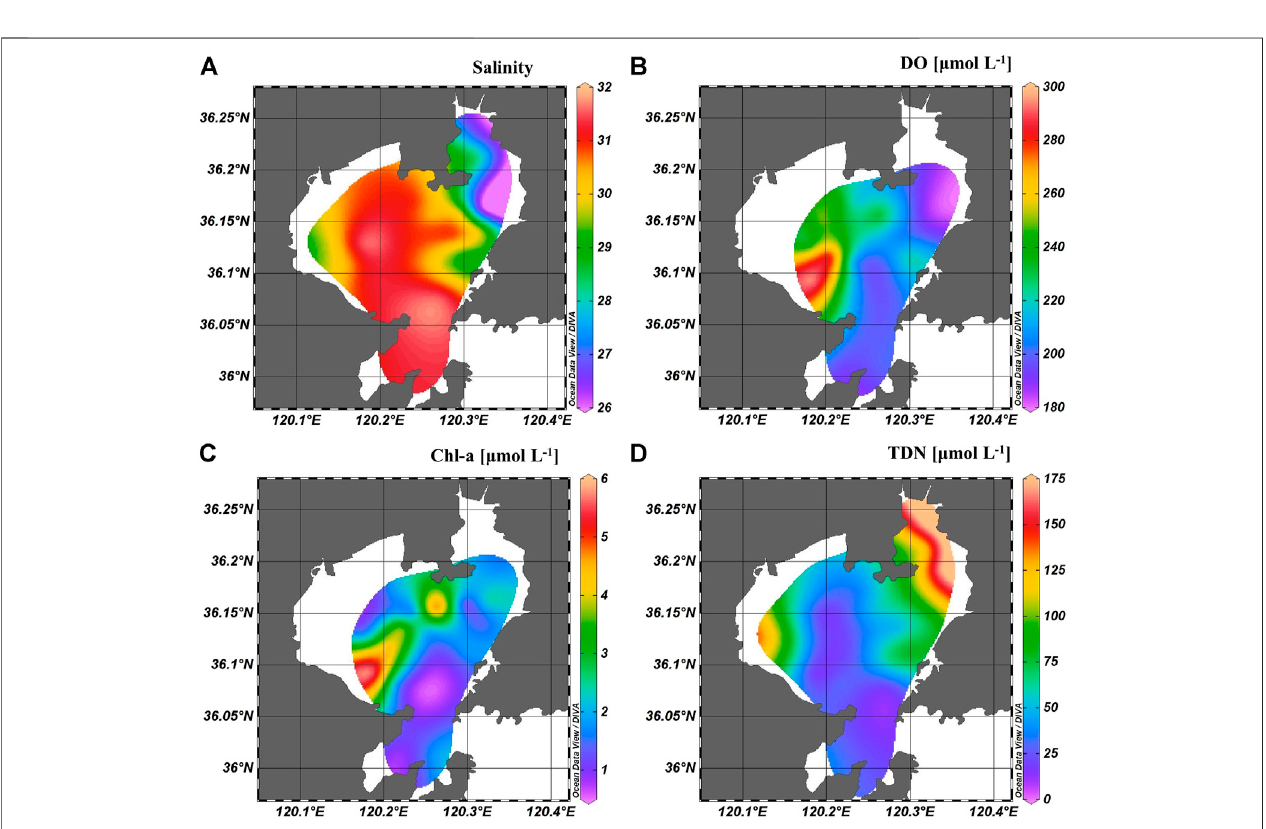
FIGURE2| Surfacedistributionofsalinity (A) ,DO (B) ,Chl-a (C) ,andTDN (D) inJiaozhouBay.This fi gurewasmadeinOceanDataView(ODV)usingDIVAgridding.